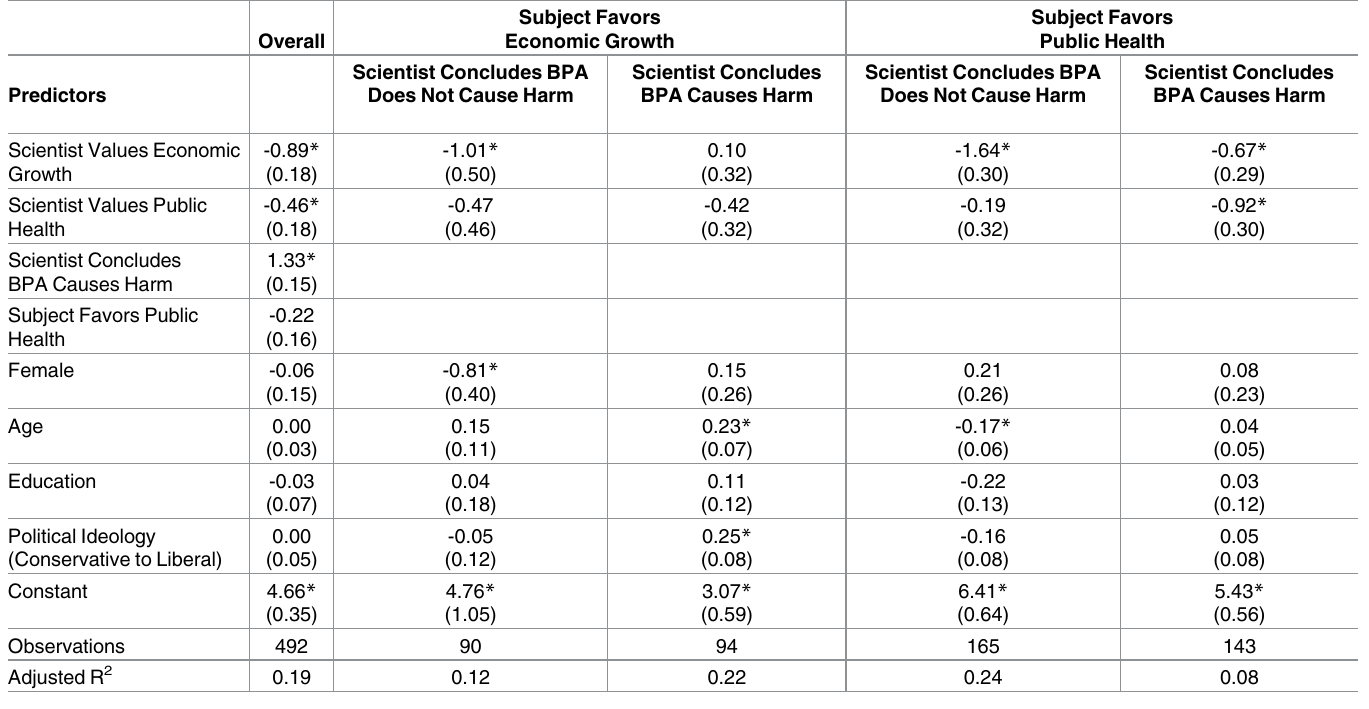
Table 2. Measuresof the effect of scientists’ conclusions and expressedvalues on respondents’ trust (Experiment 1).